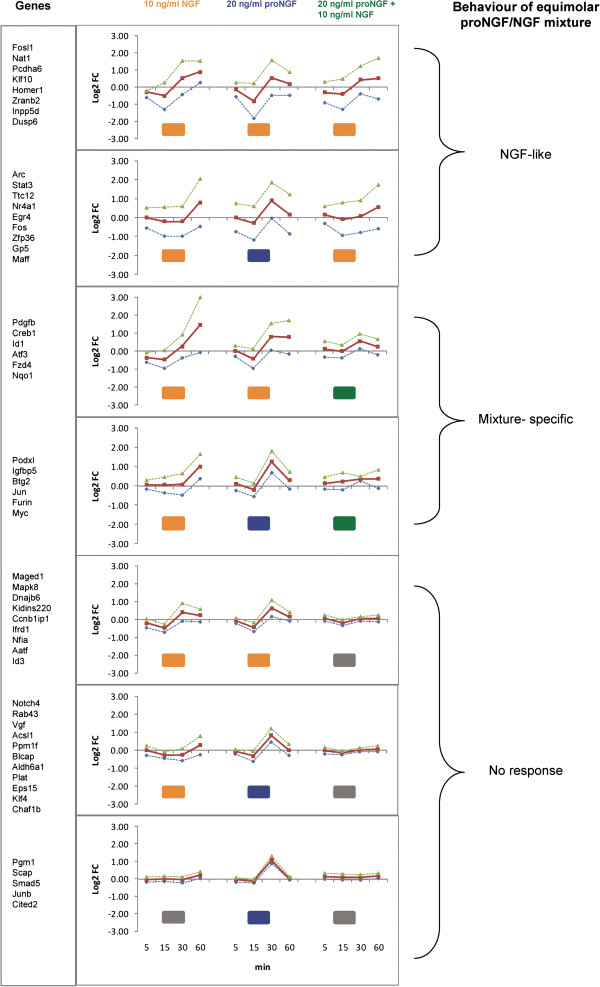
Time course of gene expression profiles. The figure shows the summary plots of expression profiles of selected genes, in three different experimental conditions, at 5, 15, 30 and 60 minutes after treatment. The expression level is the Log2 Fold Change ratio relative to the untreated condition. Each subplot is composed by three lines: the average expression value for the genes written on the left (red), average – standard deviation (dotted green), average + standard deviation (dotted blue). Every frame corresponds to a different cluster of genes and is composed by three plots: the response to 10 ng/ml NGF (left), the response to 20 ng/ml proNGF (center), the response to a mixture of 10 ng/ml NGF + 20 ng/ml proNGF (right). To evaluate the similarity between the responses to the three treatments the “centered Pearson” correlation coefficients (NGF, proNGF), (NGF, mixture), (proNGF, mixture) have been computed for each gene expression profile. The colours of the small rectangles below each plot indicate the similarity between the responses within each cluster, based on the correlation coefficients (where coefficients > 60% the profiles are considered similar): orange = NGF-like profile, blue = proNGF-like profile, green = mixture-like profile, grey = almost no response. The notes on the right summarize the response to the mixture of 10 ng/ml NGF + 20 ng/ml proNGF.